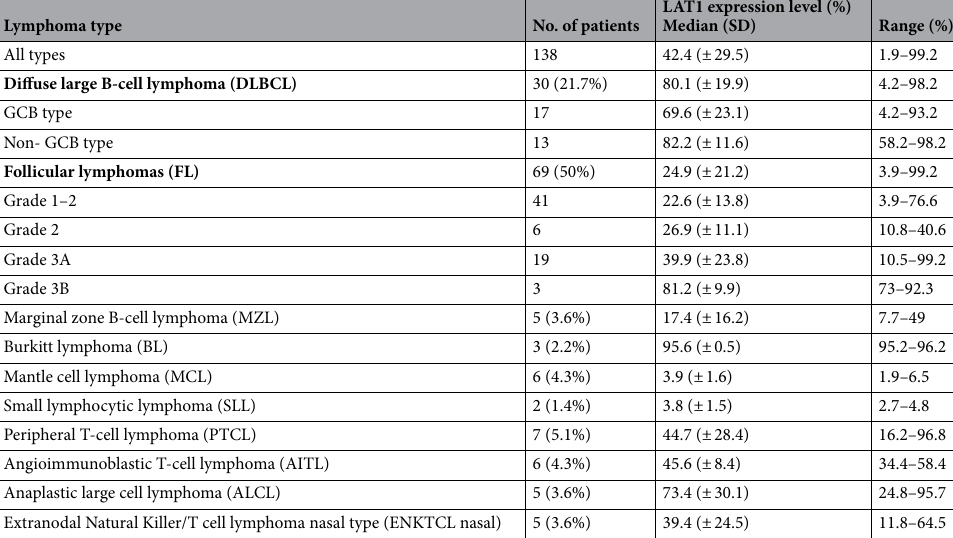
Table 2. LAT1 expression in 138 patients with Non-Hodgkin’s lymphoma (WHO classification).